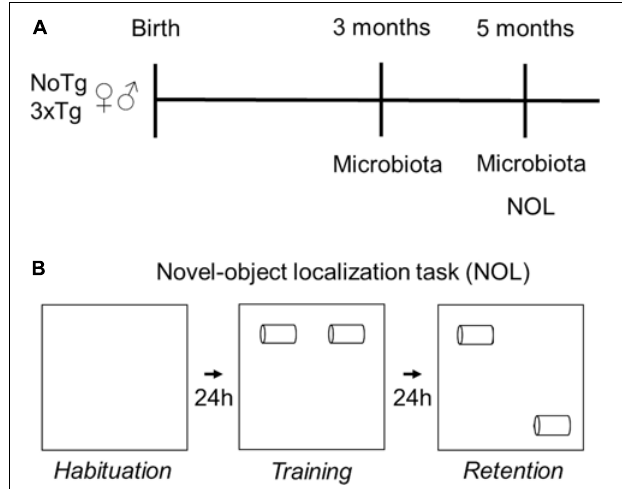
FIGURE 1 | Experimental design. (A) Fecal samples of female and male non-transgenic (NoTg) or Alzheimer’s disease triple-transgenic (3xTg-AD) mice were collected when they were 3 and 5 months old. (B) NOL task was performed in 5-month-old mice. NOL consists of three sessions: habituation, training, and retention